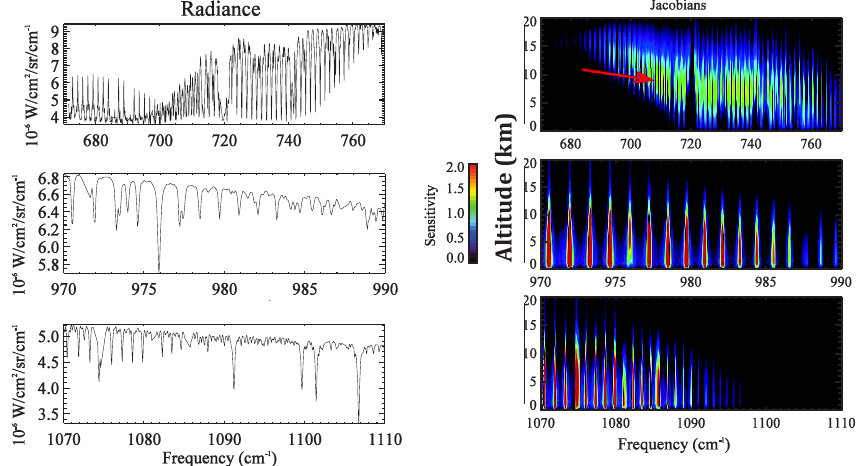
Fig. 2. Radiances and Jacobians for the three CO 2 bands used in the retrievals. The Jacobians show the sensitivity of radiances to changes in CO 2 at different altitudes. The red arrow shows the sensitivity of the radiance at 710cm − 1 when CO 2 at 10km is changed. The Jacobians have been divided by the radiance noise, so a value of 1 means that the radiance will change by the same amount as the expected radiance noise.